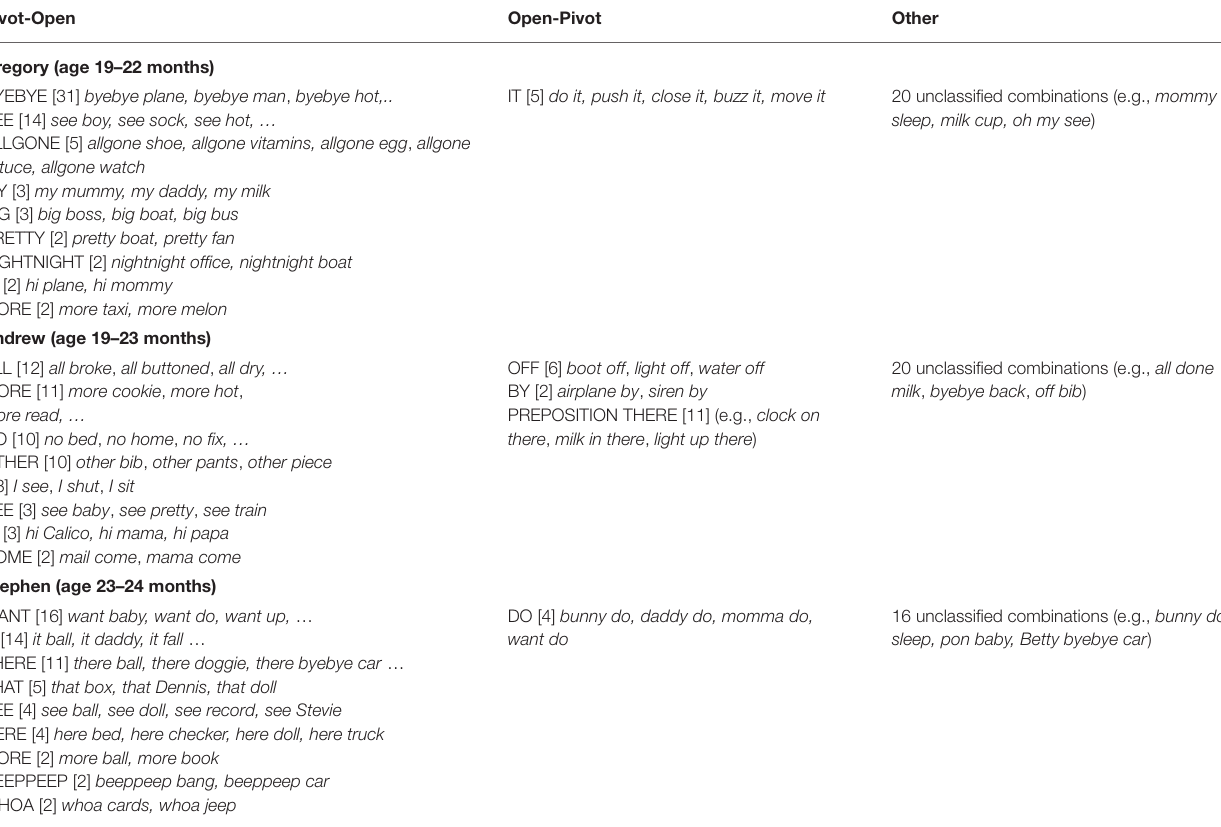
TABLE 1 | Analysis of speech data from three children (Braine, 1963). Pivot-Open